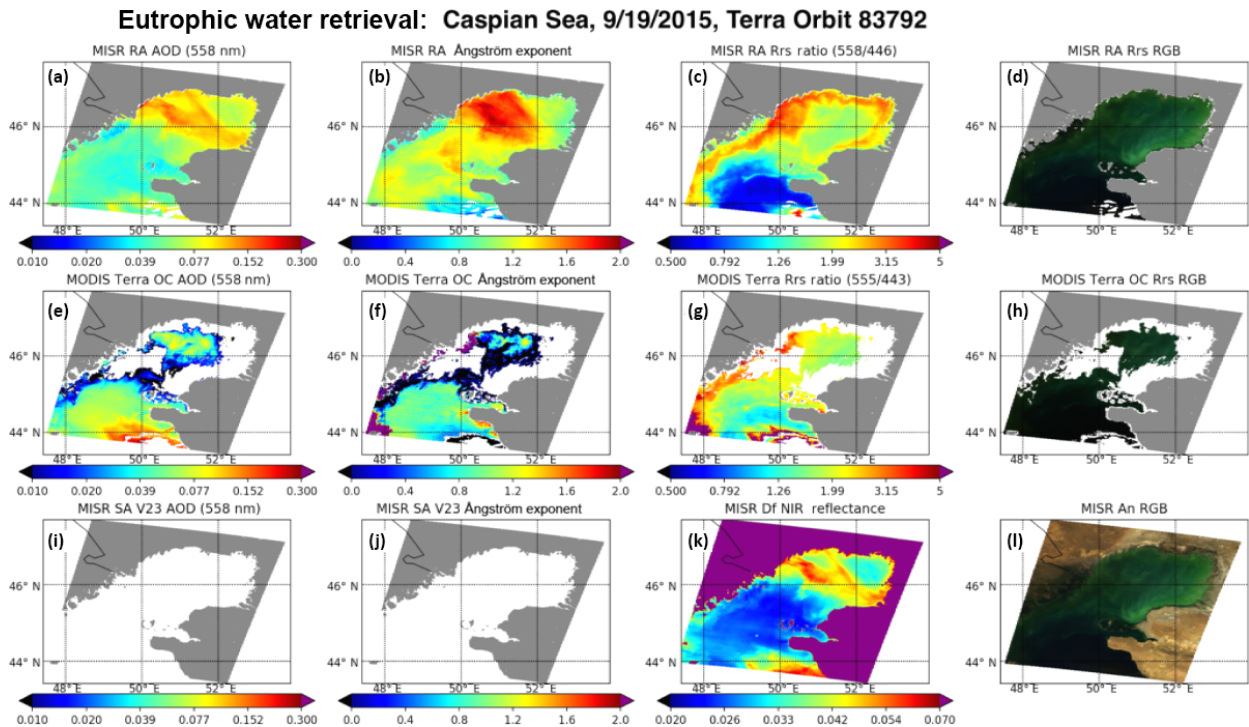
Figure 3. Same as Fig. 1, except for eutrophic waters found in the northern Caspian Sea. MISR imagery acquired on 19 September 2015, 07:42Z: Terra Orbit 83792, blocks 53–55. Note that there are no MISR SA V23 over-water retrievals for this